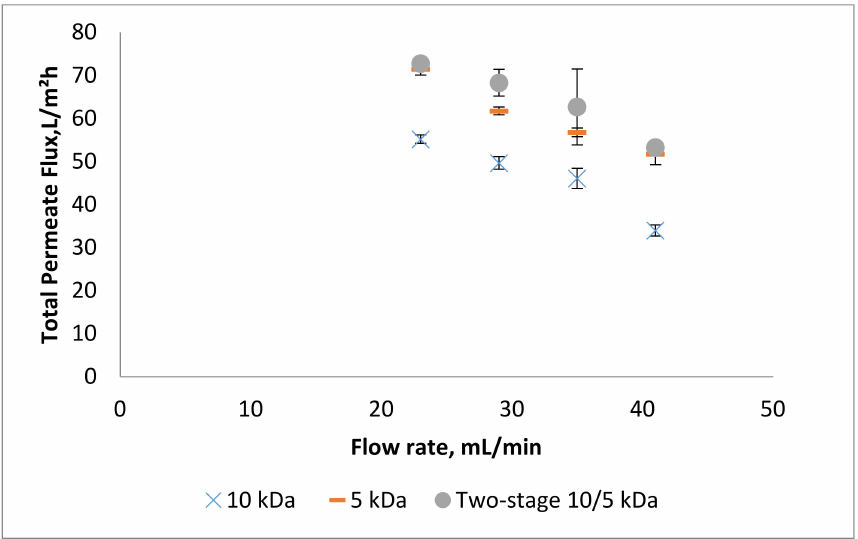
Figure 3. Total permeate flux at different feed flow rate for single and two stage ultrafiltration (UF)